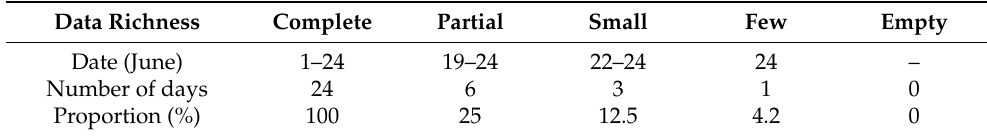
Table 2. Five categories of data richness for Test-Support set. Data Richness Complete Partial Small Few